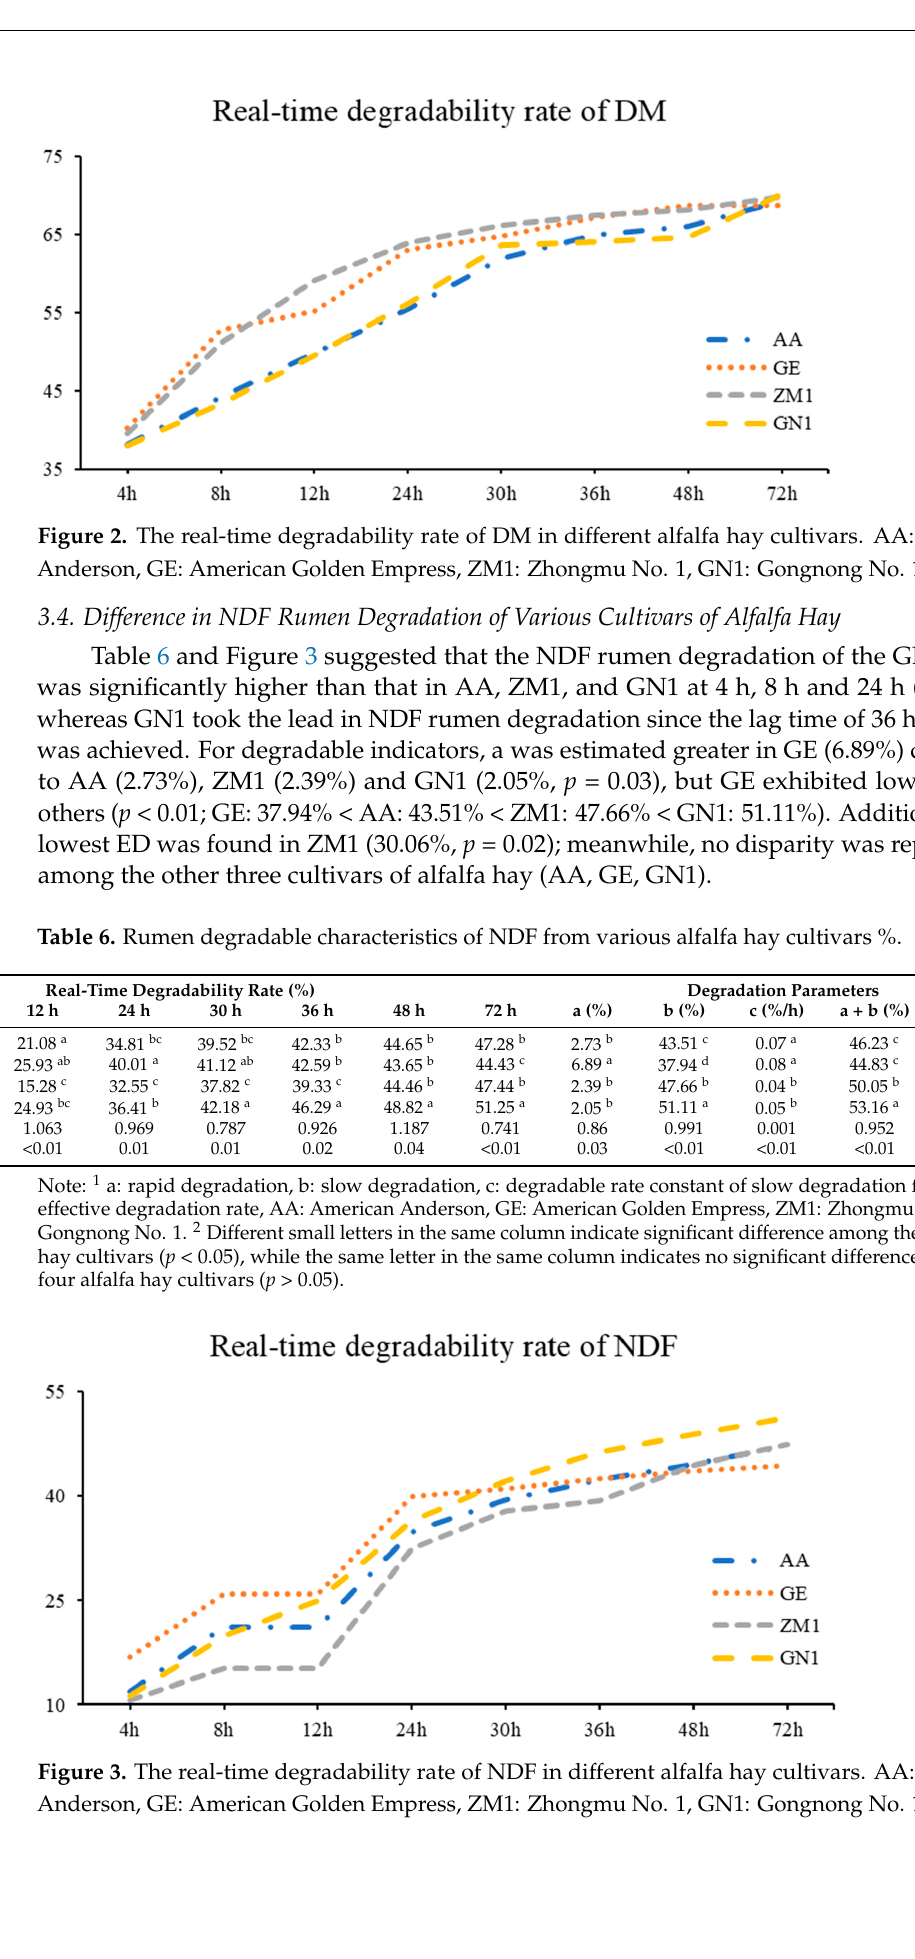
was estimated in GE, compared to AA, ZM1 and GN1 cultivars ( p < 0.01). Both GE and GN1 showed the greatest degradation of ADF until the lag time in rumen up to 24 h and 30 h ( p < 0.05). At the time point of 48 h and 72 h, GN1 was far higher than the other three cultivars of alfalfa hay ( p = 0.01). For degradation parameters, a and a + b of ADF were greatest in GE ( p < 0.01), and no significant difference was estimated among the other three cultivars. In addition, ED was marked higher in GE (30.73%) and GN1 (30.84%) compared to AA (28.23%) and ZM1 (27.01%, p < 0.01), but no difference was found between GE and GN1 or AA and ZM1. Table 7. Rumen degradable characteristics of ADF from various alfalfa hay cultivars %. Items 1